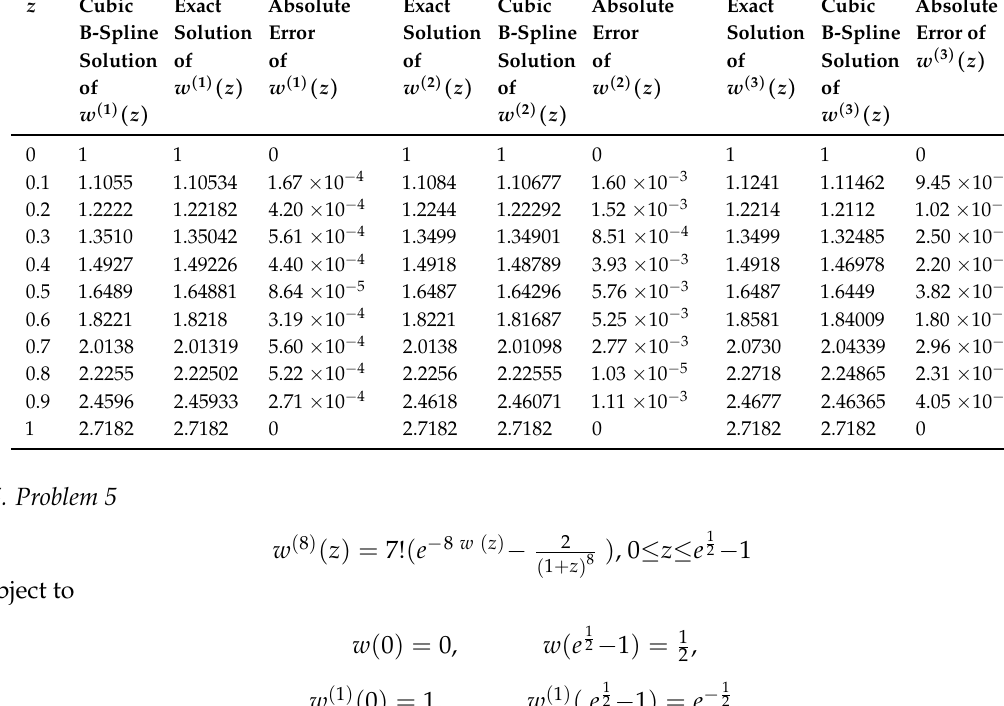
where boundary conditions are defined in 10